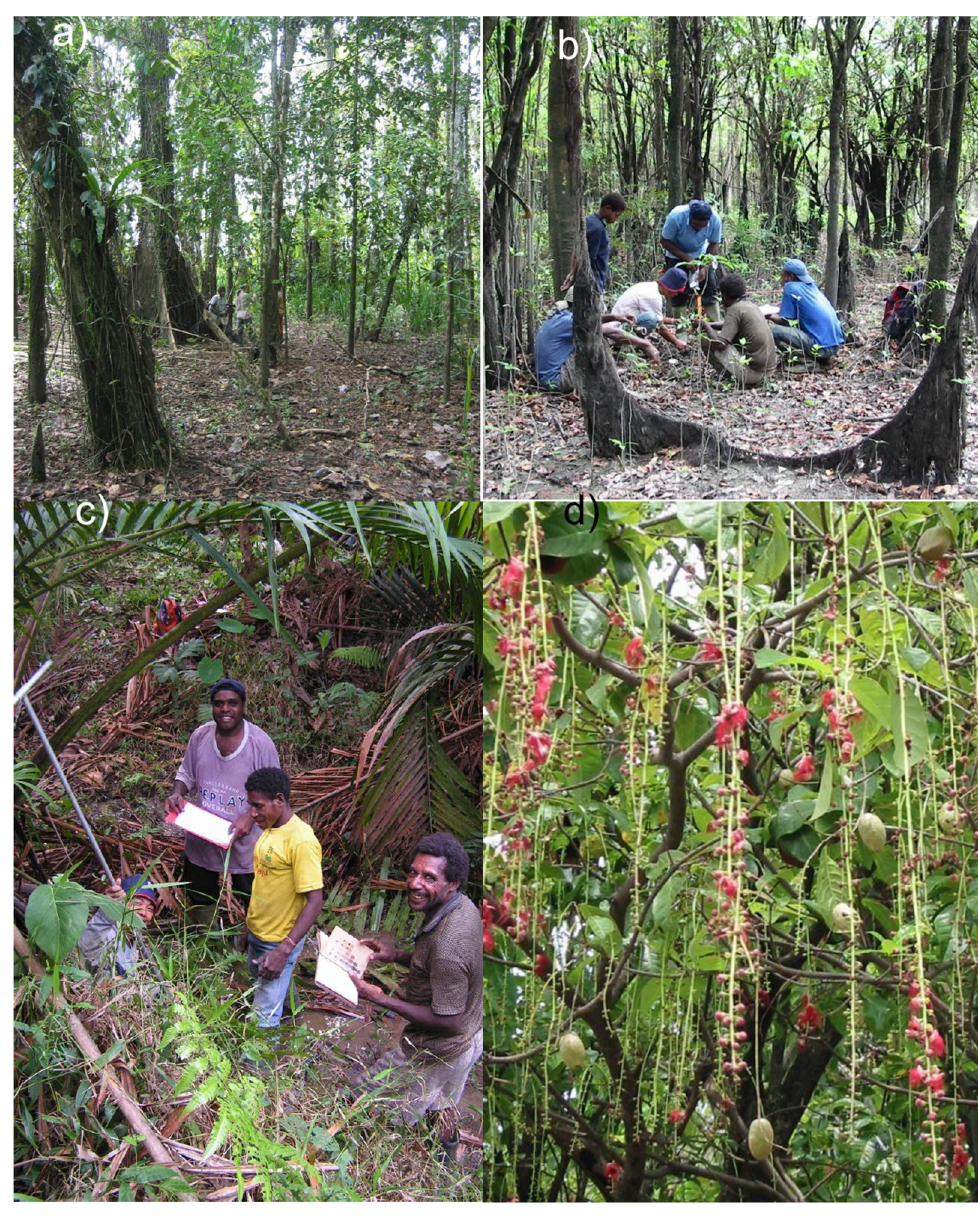
Figure 3. Floodplain forests in the Mamberamo Basin include swamp forests ( a ), seasonally flooded lakeside forests ( b ), and sago forests ( c ) and included distinctive trees such as these flowering Barringtonia sp. ( d ). Credits: MB, MvH, DS, and MvH.